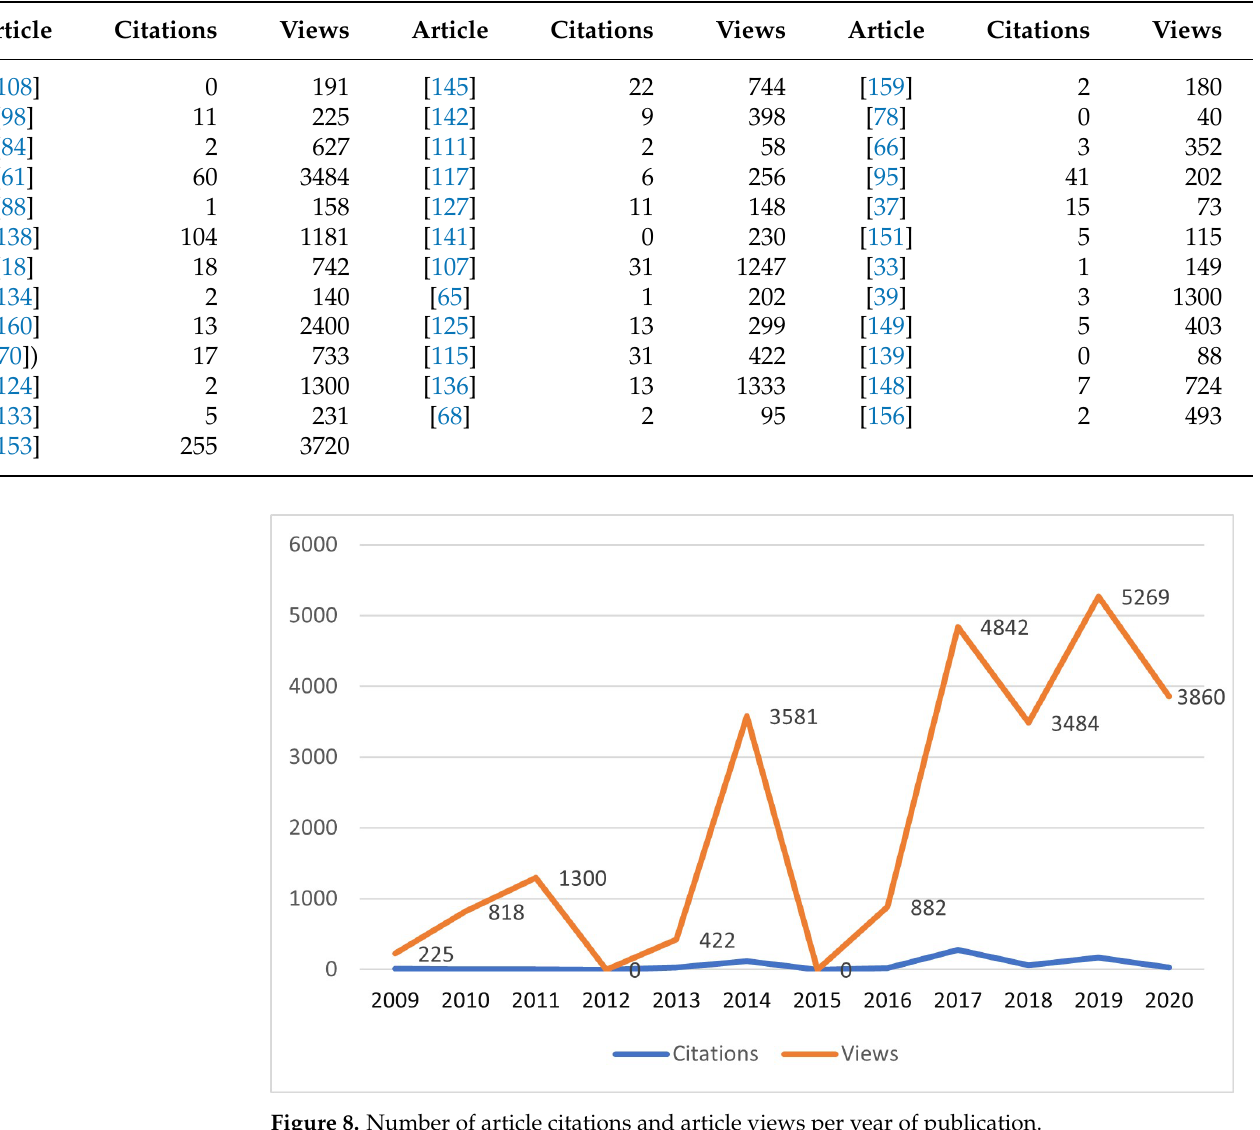
Figure 8. Number of article citations and article views per year of